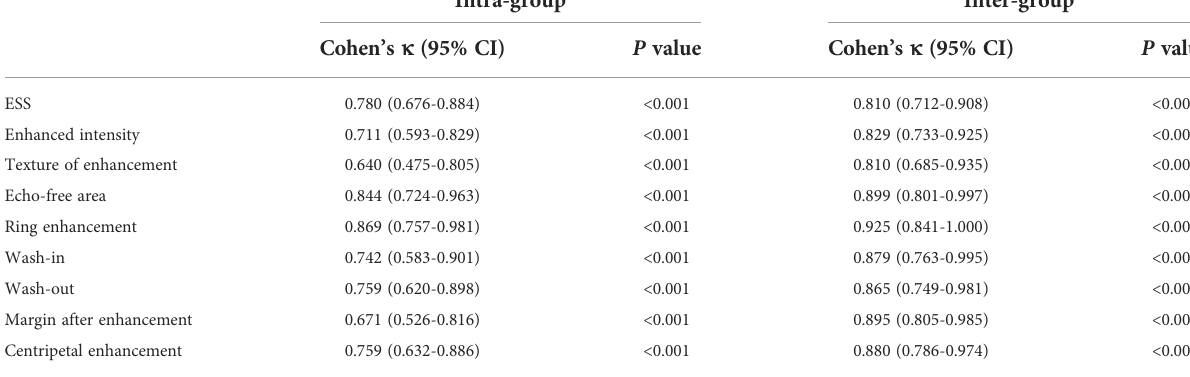
TABLE 5 Intra- and inter-group consistency tests for ESS and CEUS